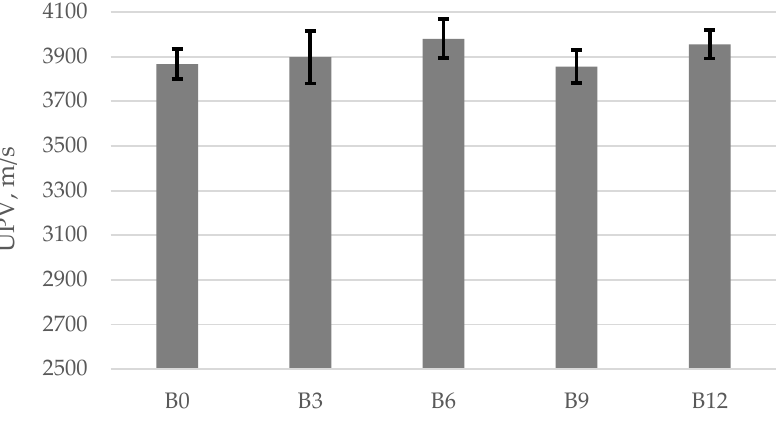
Figure 3. Ultrasonic pulse velocity.